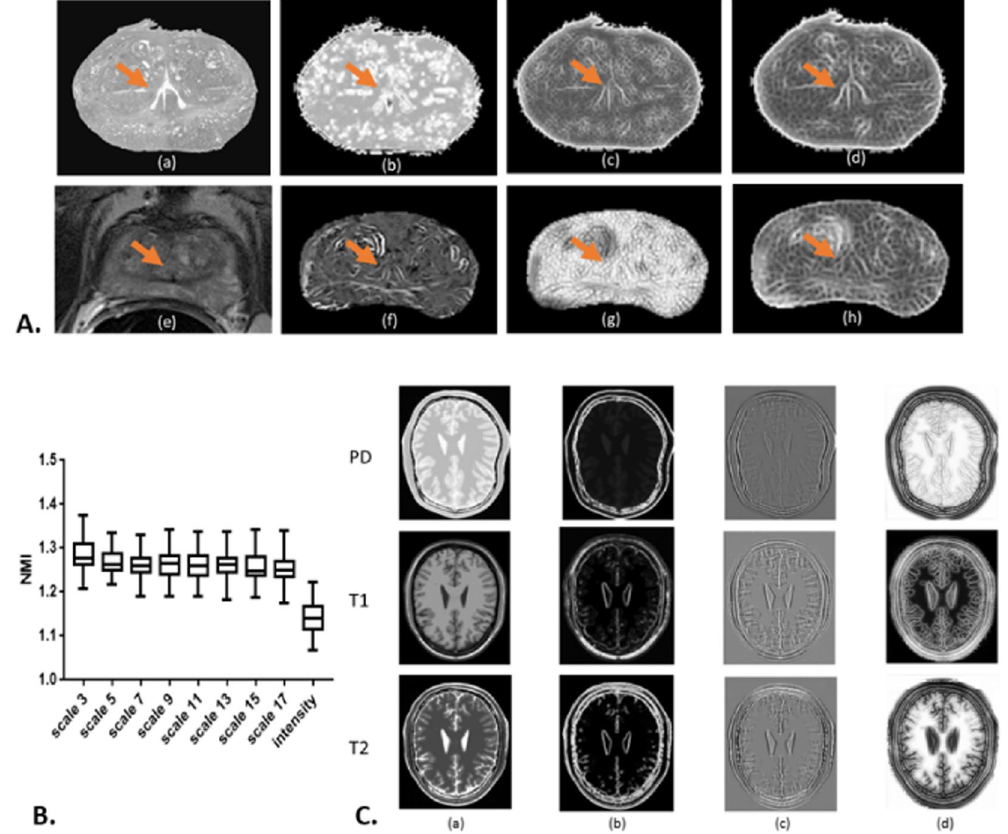
Figure 3. In Figure 3 Panel A, sub-panel (a) shows the down-sampled gray scale histopathology image and (e) shows the corresponding T2 weighted MRI slice. (b–d) are SE based representations of histopathology and (f–h) are MRI derived SE representations at scales κ ∈ {3, 11, 17}, respectively. The orange arrows point to the urethra structures. Panel B illustrates the NMI distribution for each scale representation across 45 pairs of histopathology images and MRI. Marked improvement in similarity is observed across all scales and reflected via a greater NMI of SE representations compared to intensity - based representations. In Panel C, column (a) shows the intensity representation of corresponding PD, T1 and T2 MRI and columns (b–d) show their corresponding SE representations at scales κ ∈ {3, 9, 17}, respectively. SE representations across different scales emphasize different attributes in the image, attributes that only become apparent at specific length scales. For instance, for clinical data, the region corresponding to the urethra is de-emphasized in the representations shown in (b) and (g). On the other hand, (c), (d), (f) and (h) highlight and emphasize the same regions. In addition, synthetic data SE representations in Panel C, sub-panel (c) illustrate underlying similarities across different modalities compared to sub-panels (a), (b) and